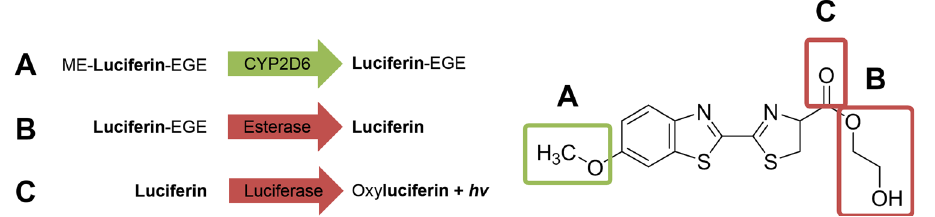
Figure 1. Essential steps of the luminescence-based, high-throughput P450-Glo CYP2D6 inhibition assay. ( A ) Methoxy-luciferin-ethylene glycol ester is a CYP2D6 substrate that is demethylated to luciferin-ethylene glycol ester in the presence of NADPH, which serves as an electron source. ( B ) The read-out of the CYP2D6 reaction is based on the treatment of the reaction mixture with the detection reagent that consists of a detergent, an unspecific esterase and a modified firefly-luciferase. ( C ) The esterase continuously generates luciferin, which is oxidized by the firefly-luciferase and thereby a stable luminogenic signal is produced.